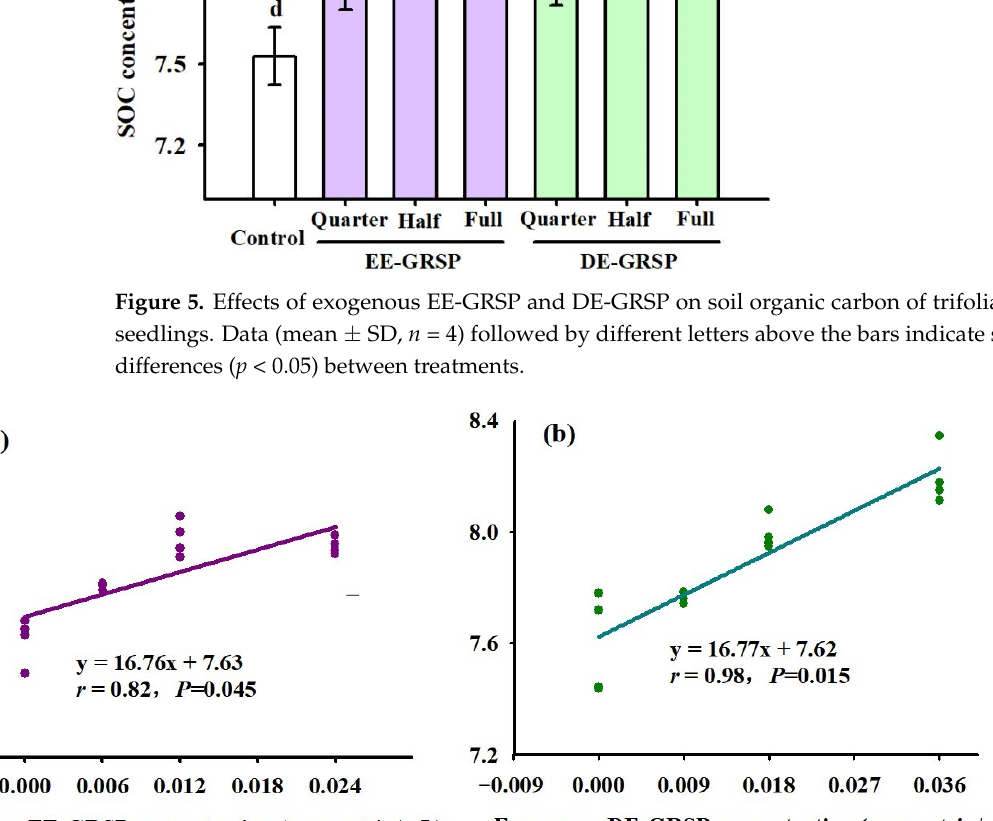
Figure 6. Correlation between exogenous EE-GRSP ( a ) and exogenous DE-GRSP ( b ) and soil organic carbon ( n = 16).